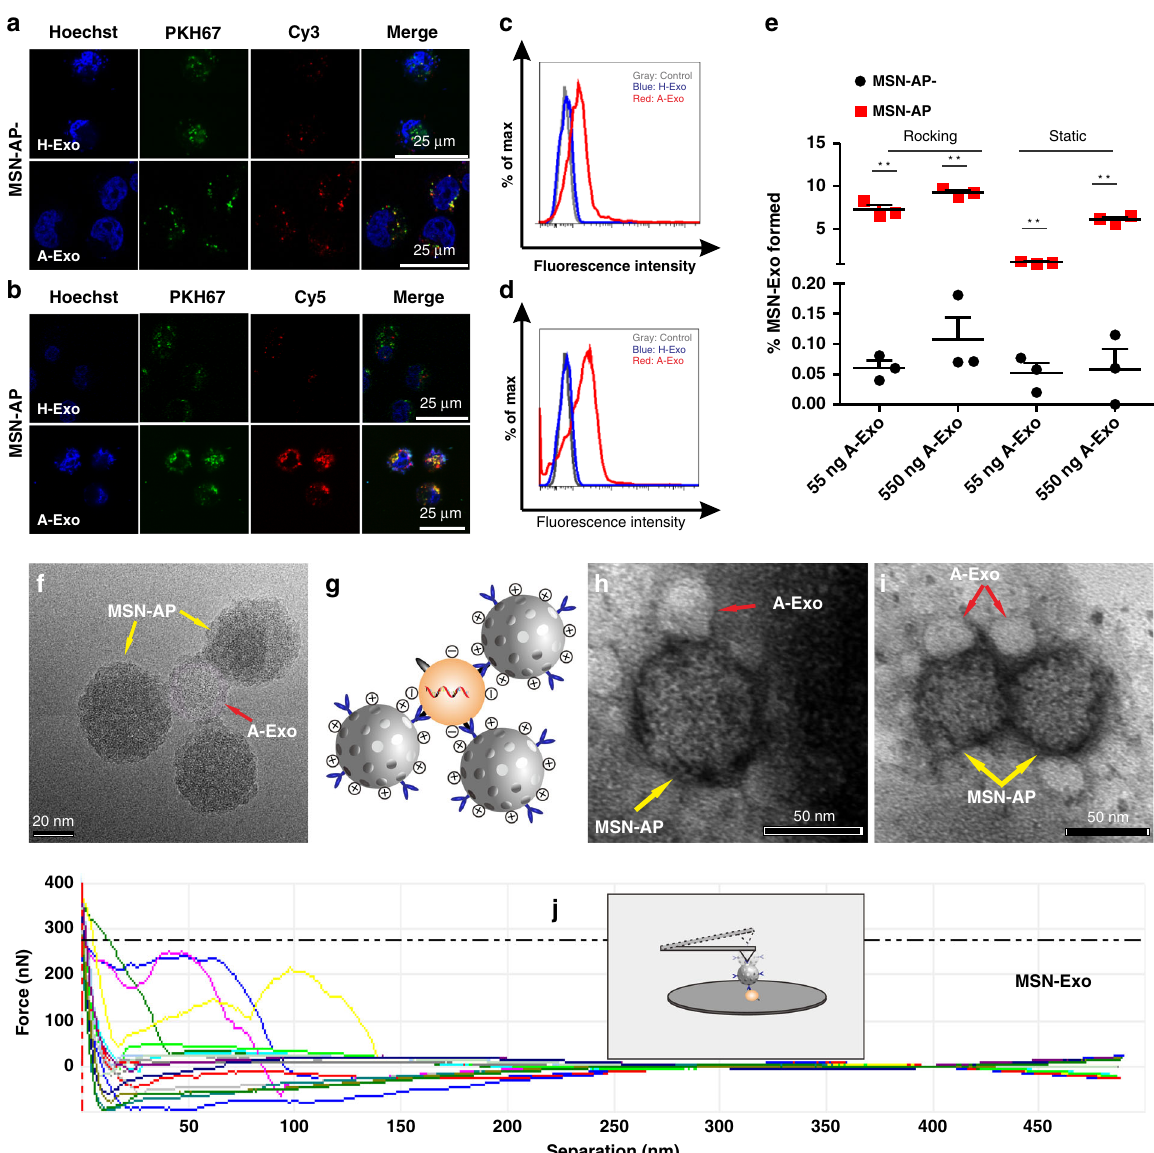
Fig. 3 Recognition and binding between MSN-AP and A-Exo in cell media and rat blood. a , b Fluorescence microscopy of the binding between A-Exo (labelled with green PKH67) and MSN-AP − ( a ; labelled with red Cy3) or MSN-AP ( b ; labelled with red Cy5) using H-Exo as a control (upper panel). Note the signi fi cant binding between A-Exo and MSN-AP (far right and lower panel in b ). c , d Flow cytometry analysis showing binding between A-Exo and MSN-AP − ( c ), or MSN-AP ( d ) using H-Exo as a control. e Flow cytometry quanti fi cation showing the percentage of A-Exo captured by MSN-AP- or MSN- AP to form MSN-Exo in rat blood after 1 h of static or rocking incubation at 37 °C. There was no signi fi cant binding between MSN-AP and H-Exo, which lacks EGFR. n = 3 independent samples. f TEM image showing the binding between MSN-AP and A-Exo in cell medium. g Schematic showing the molecular binding between the EGFR aptamer on MSN-AP and the EGFR receptor on A-Exo, as well as the electronic attraction between the positively charged MSN-AP and negatively charged A-Exo. h – i TEM images showing conjugation between MSN-AP and A-Exo in blood without ( h ) and with ( i ) rocking. j Single-molecular force spectroscopy of AFM shows the intermolecular force of the MSN-Exo conjugate corresponding to the separation distance; the inset depicts that the AFM cantilever tip attaches to MSN-Exo. Data presented as the mean ± s.e.m. ** P < 0.01, unpaired two-tailed t test. Source data are provided as a Source Data fi